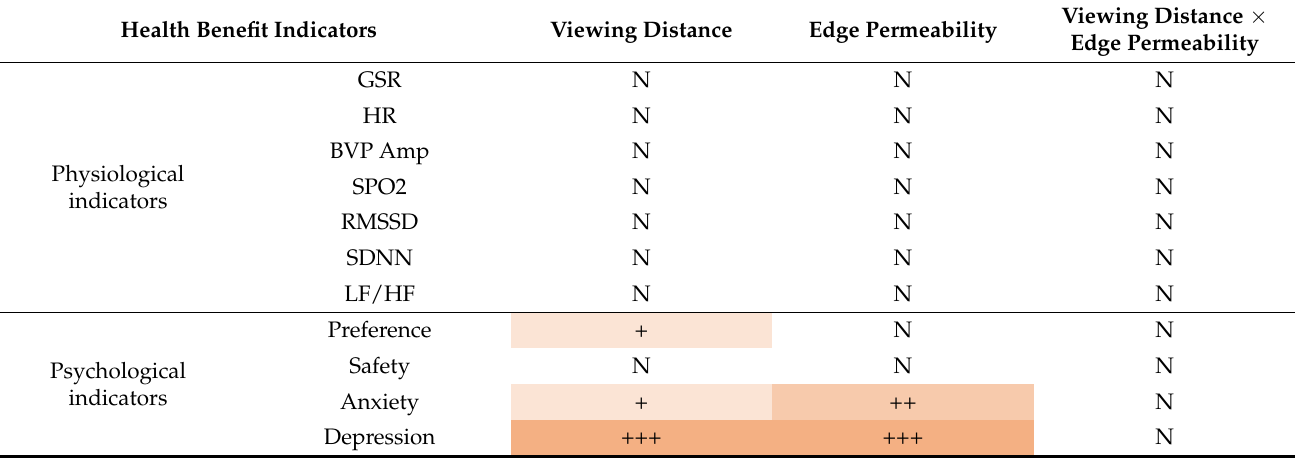
Table 11. Summary of the impacts of viewing distance and edge permeability of a grassland landscape on psychological